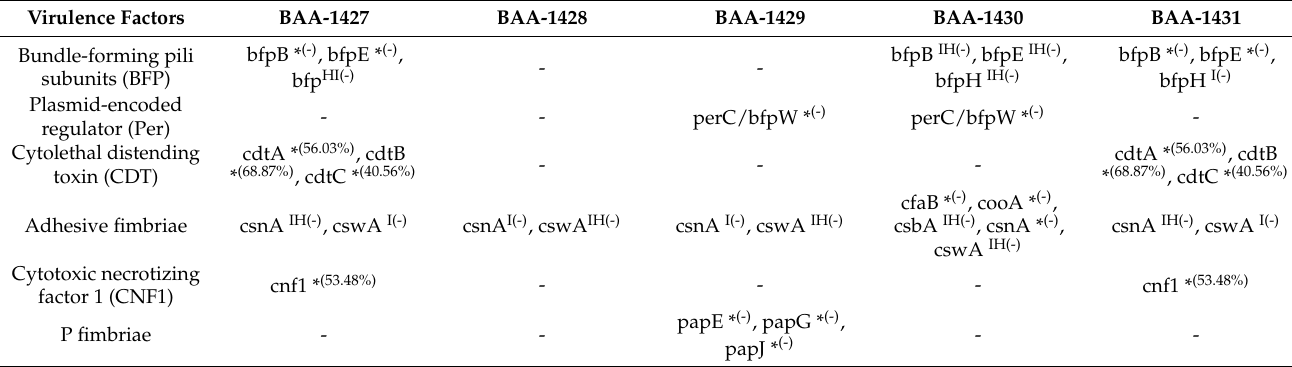
Table 4. Virulence attributes observed in bacterial surrogates. Subunits of virulence factors that were detected in each strain are indicated. An e-value limit of <0.00001 was adopted as a cut-off for protein identity (Blastx analysis). GenBank accession numbers for the virulence factors and their corresponding subunits within this table are provided in Table